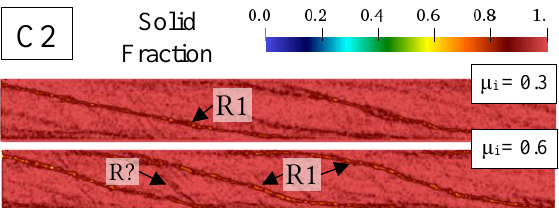
Fig. 6. Solid fraction at slip distance B2 for two different inter- particle frictions ( μ i = 0.3 & 0.6) , L 20 , letter from Fig. 5.